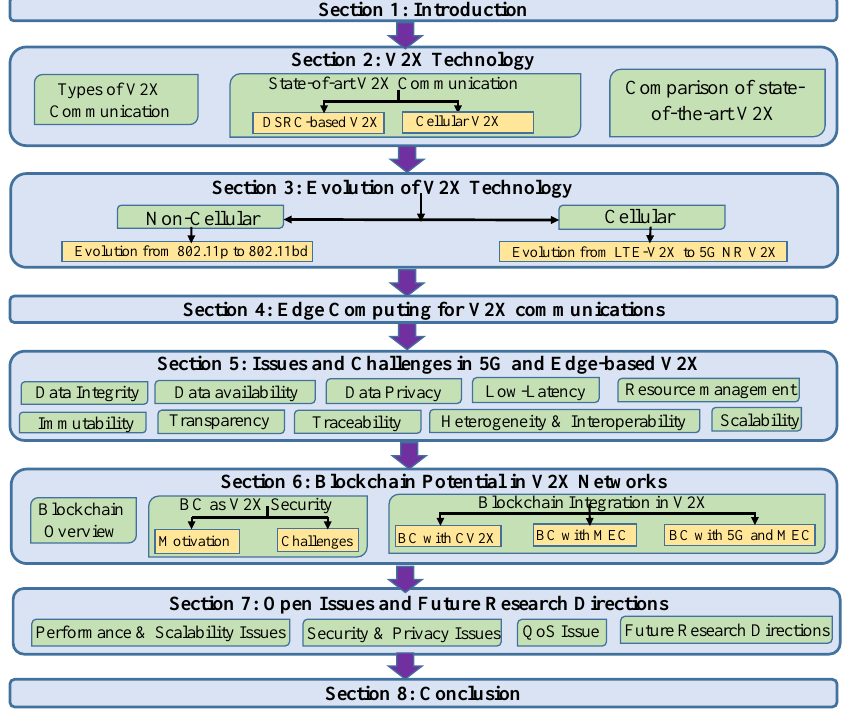
Figure 1. Structure of the survey